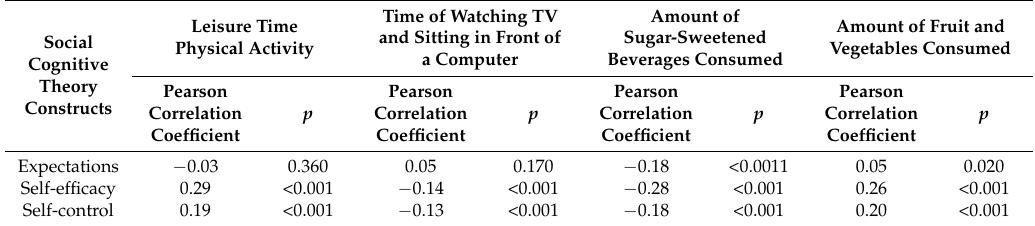
Table 4. Correlation analysis of physical activity and healthy nutrition behaviors and social cognitive theory